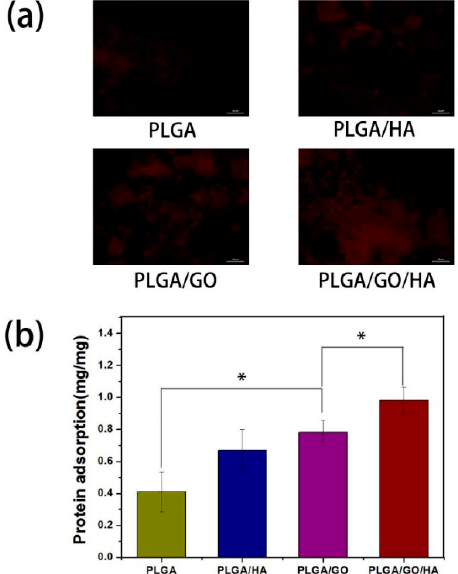
Figure 3. Protein adsorption and cell adhesion of Poly lactide-co-glycolic acid (PLGA), Poly lactide- co-glycolic acid/hydroxyapatite (PLGA/HA), PLGA/graphene oxide (GO), and